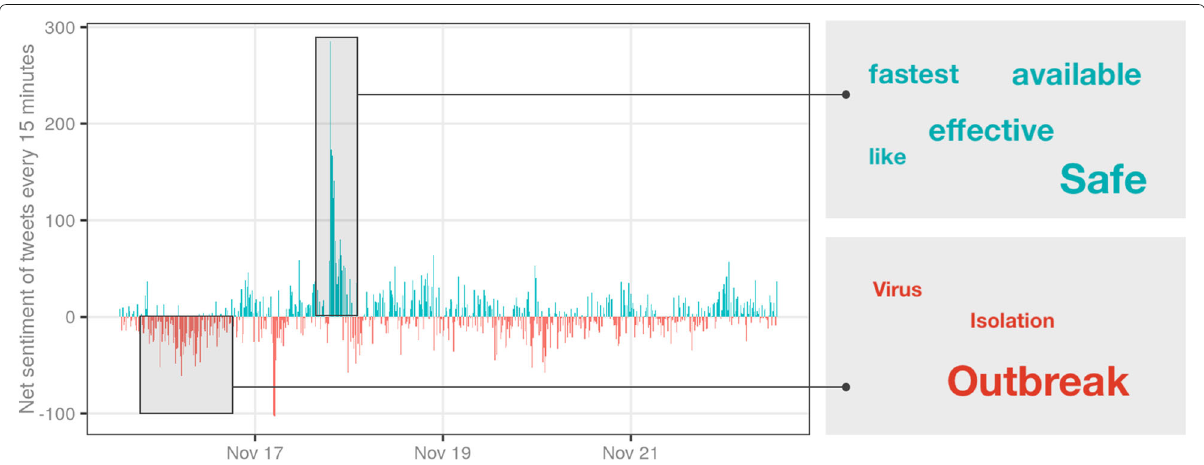
Fig. 5 Analysis of tweets collected between 15 and 22nd November 2020 showing the negative and positive sentiments associated with the